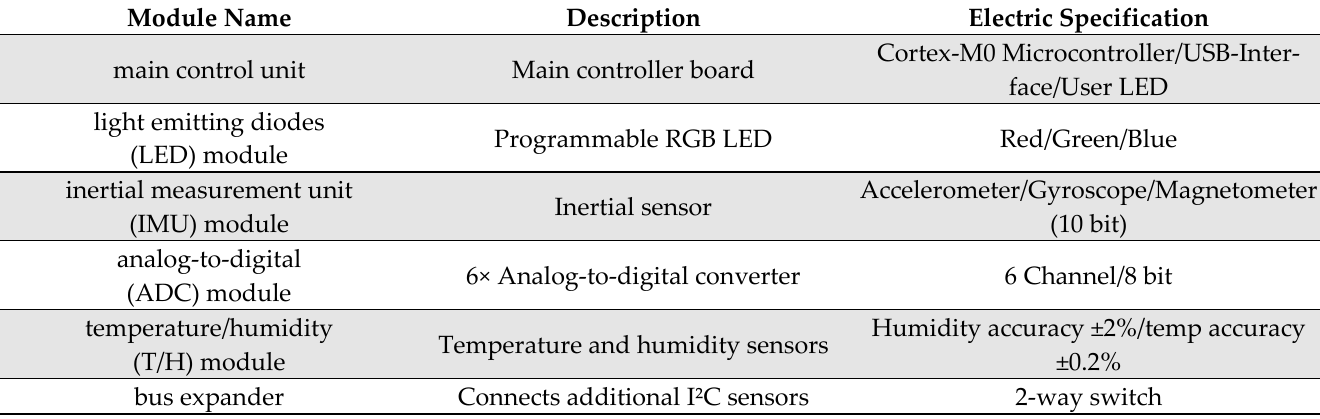
Table 1. Textile Prototyping Lab (TPL) toolkit module